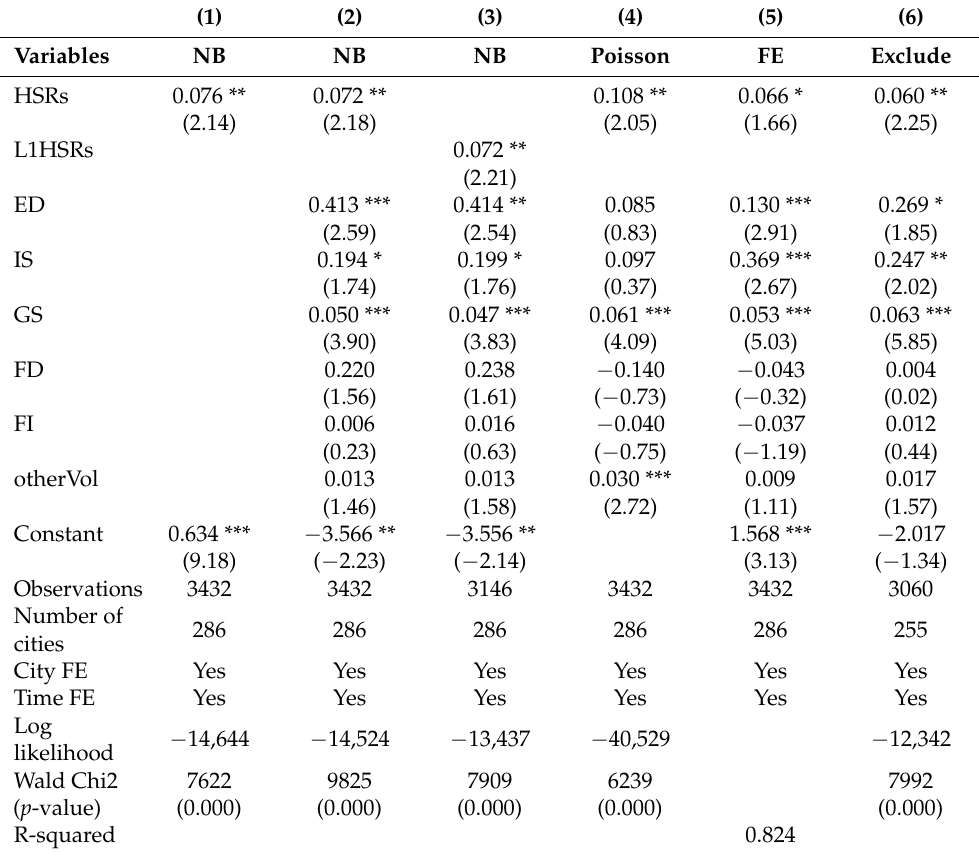
Table 2. Baseline regression and robustness